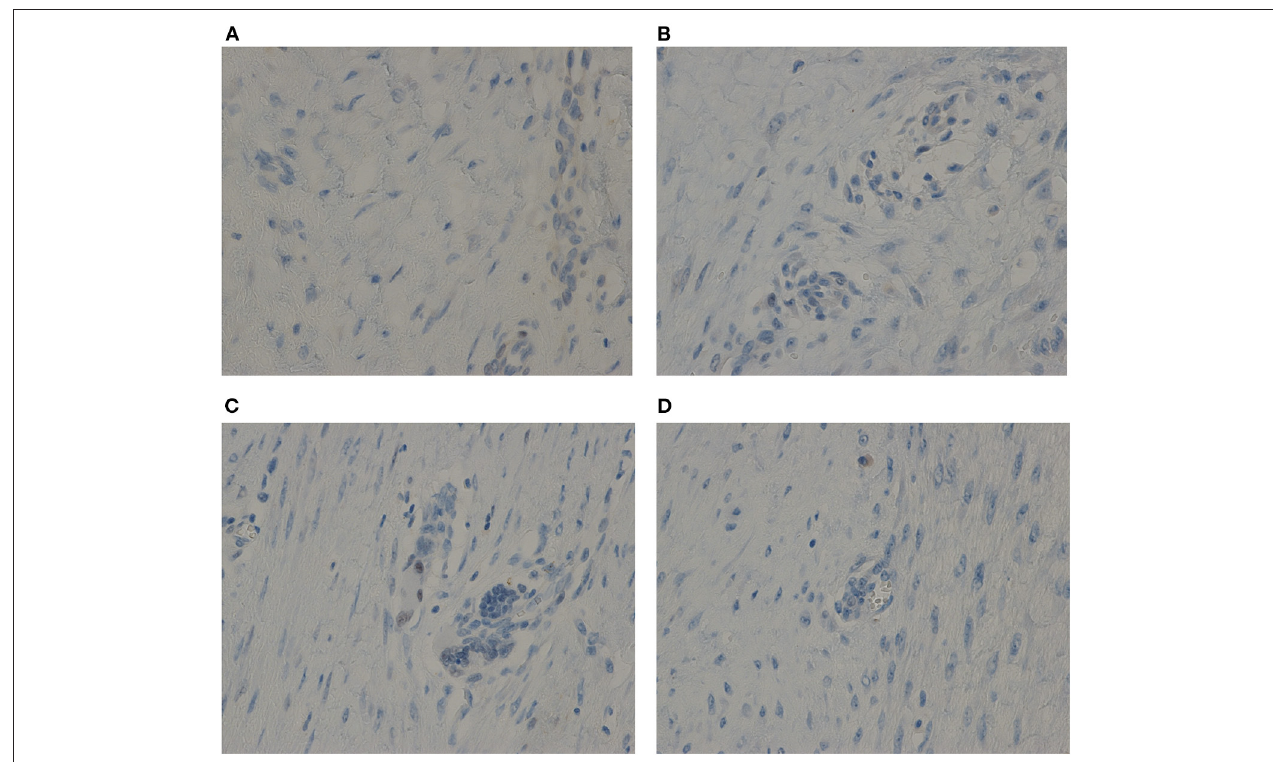
FIGURE 2 | The immunohistochemical testing showed negative results for both ER and PR in the two cases. (A) For ER of Case one. (B) For PR of Case one. (C) For ER of Case two. (D) For PR of Case two. Anti-ER or Anti-PR antibody immunostaining, ×